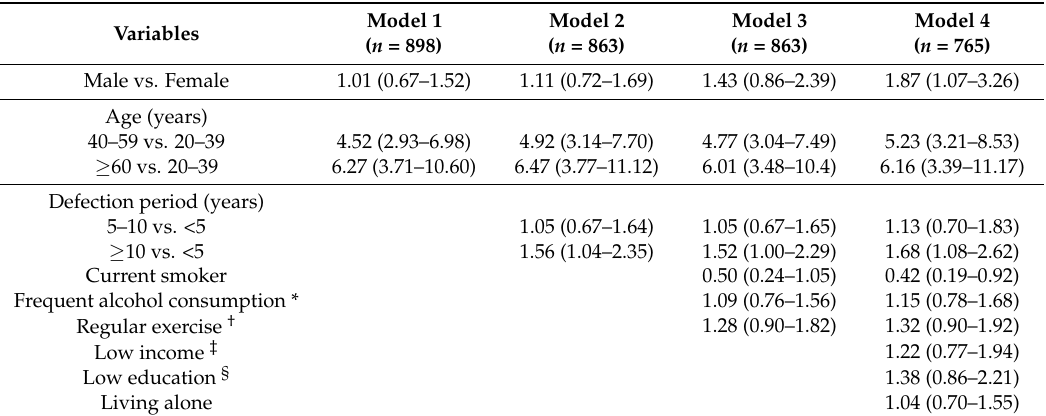
Table 4. Result of logistic regression analyses on